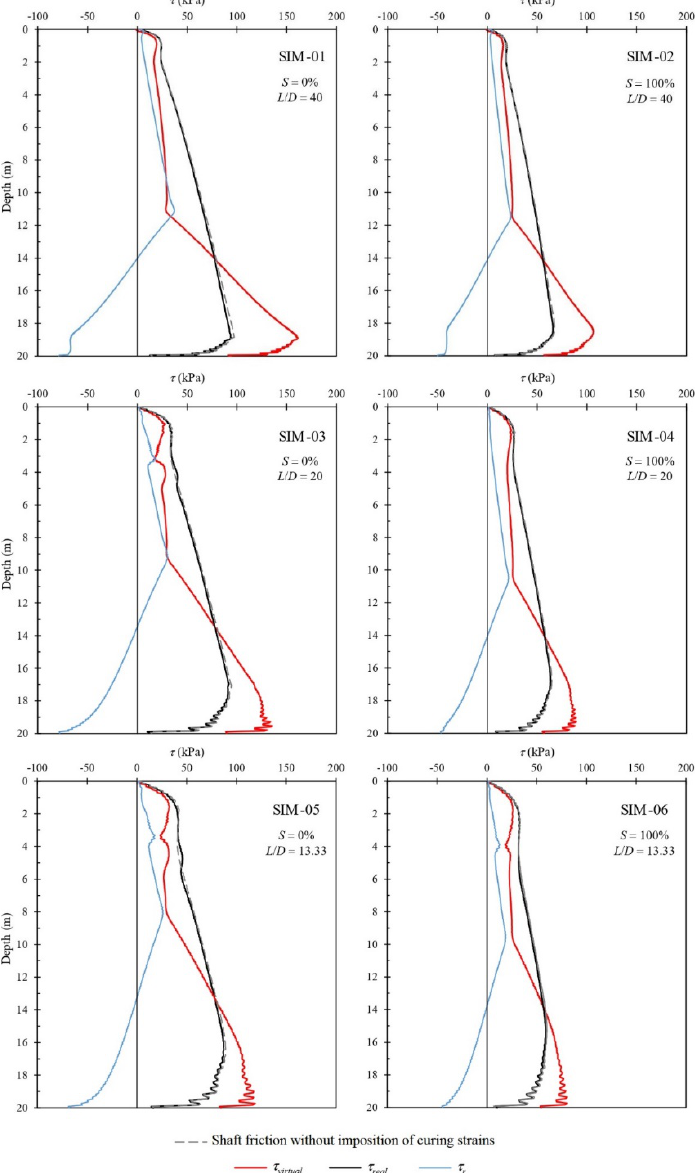
Figure 12. Distribution of unit shaft friction on soil elements adjacent to the pile for 10% D total displacement: L / D = 40 (SIM-01 and SIM-02), L / D = 20 (SIM-03 and SIM-04), and L / D = 13.33 (SIM-05 and